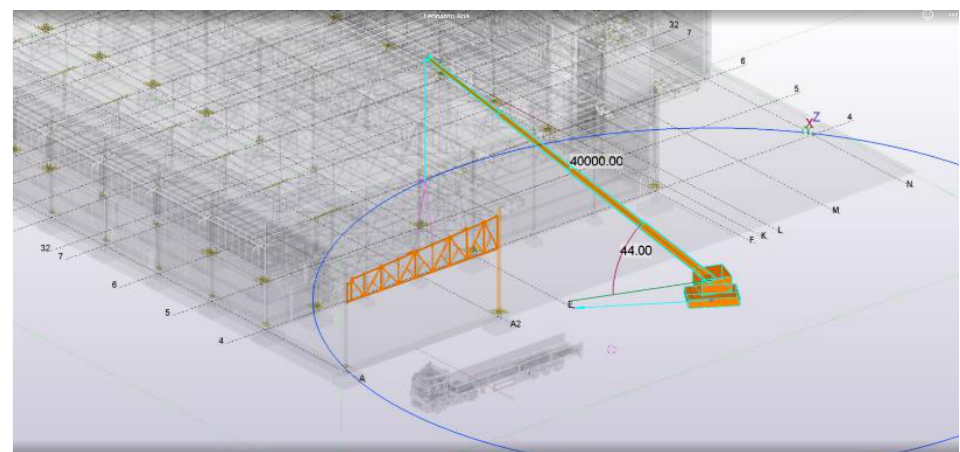
Figure 21. BIM-DFE-Erection model.